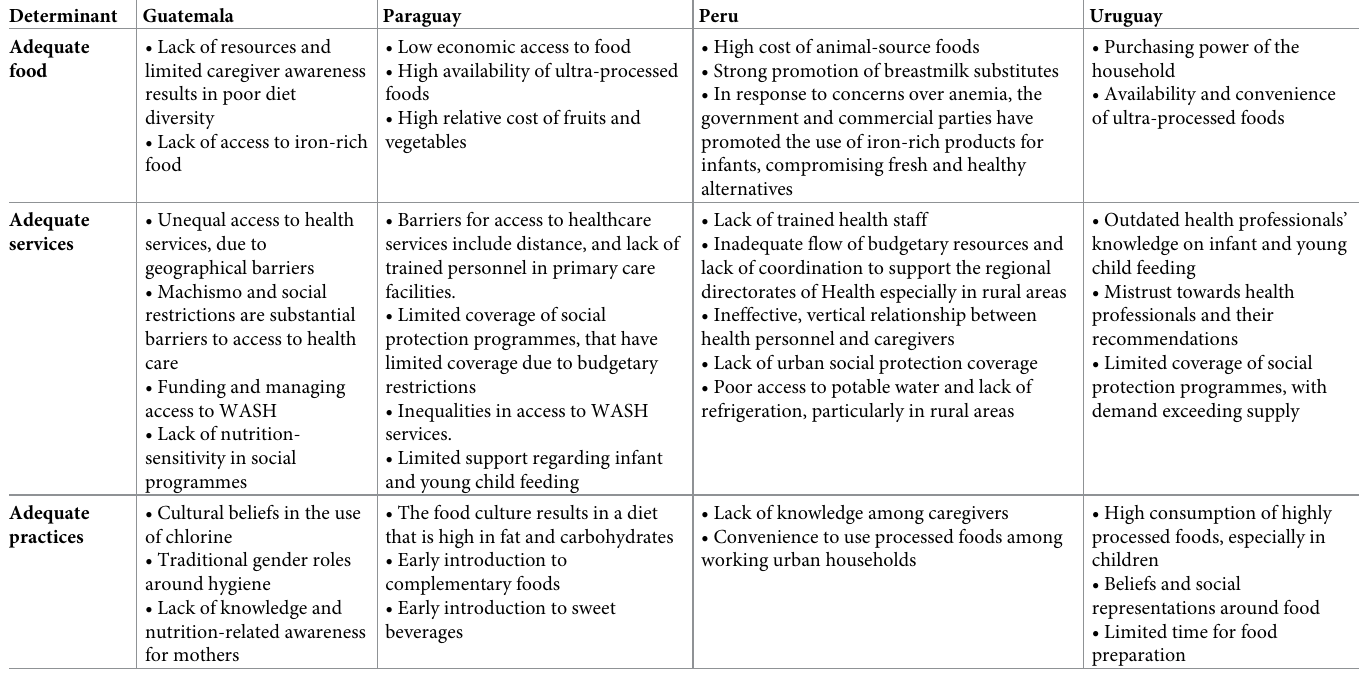
Table 3. Summary of drivers of children’s diets per determinant based on key informant interviews, by country. Determinant